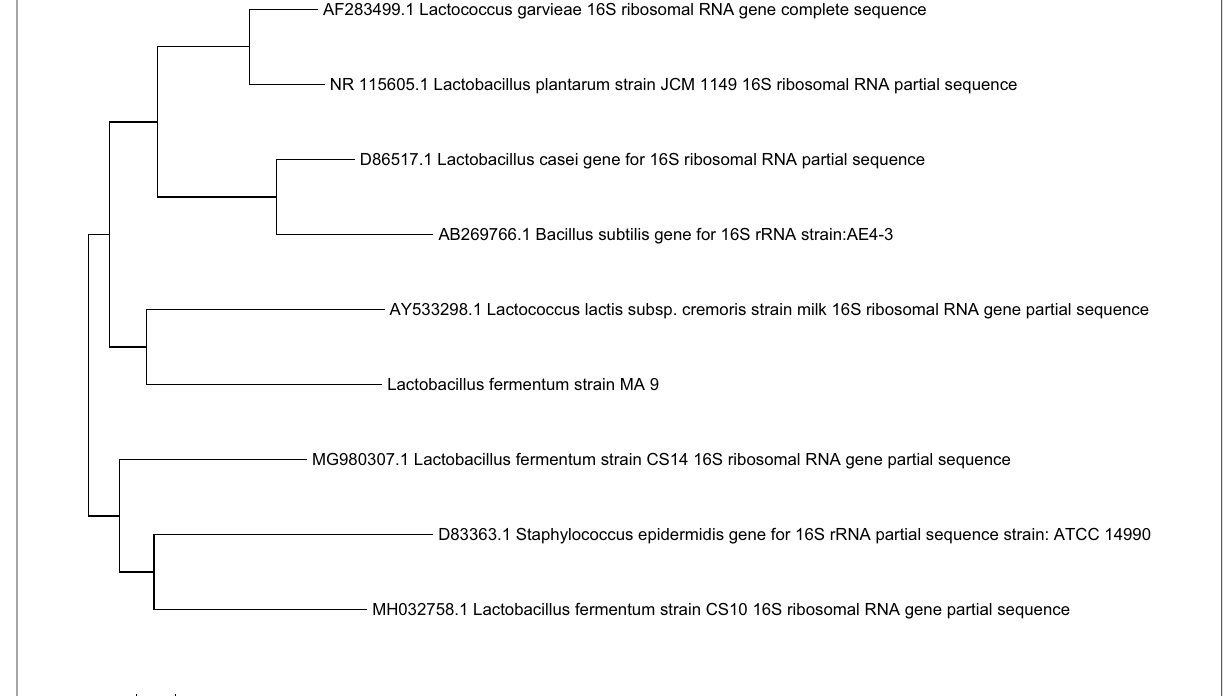
Fig. 2 Phylogenetic tree